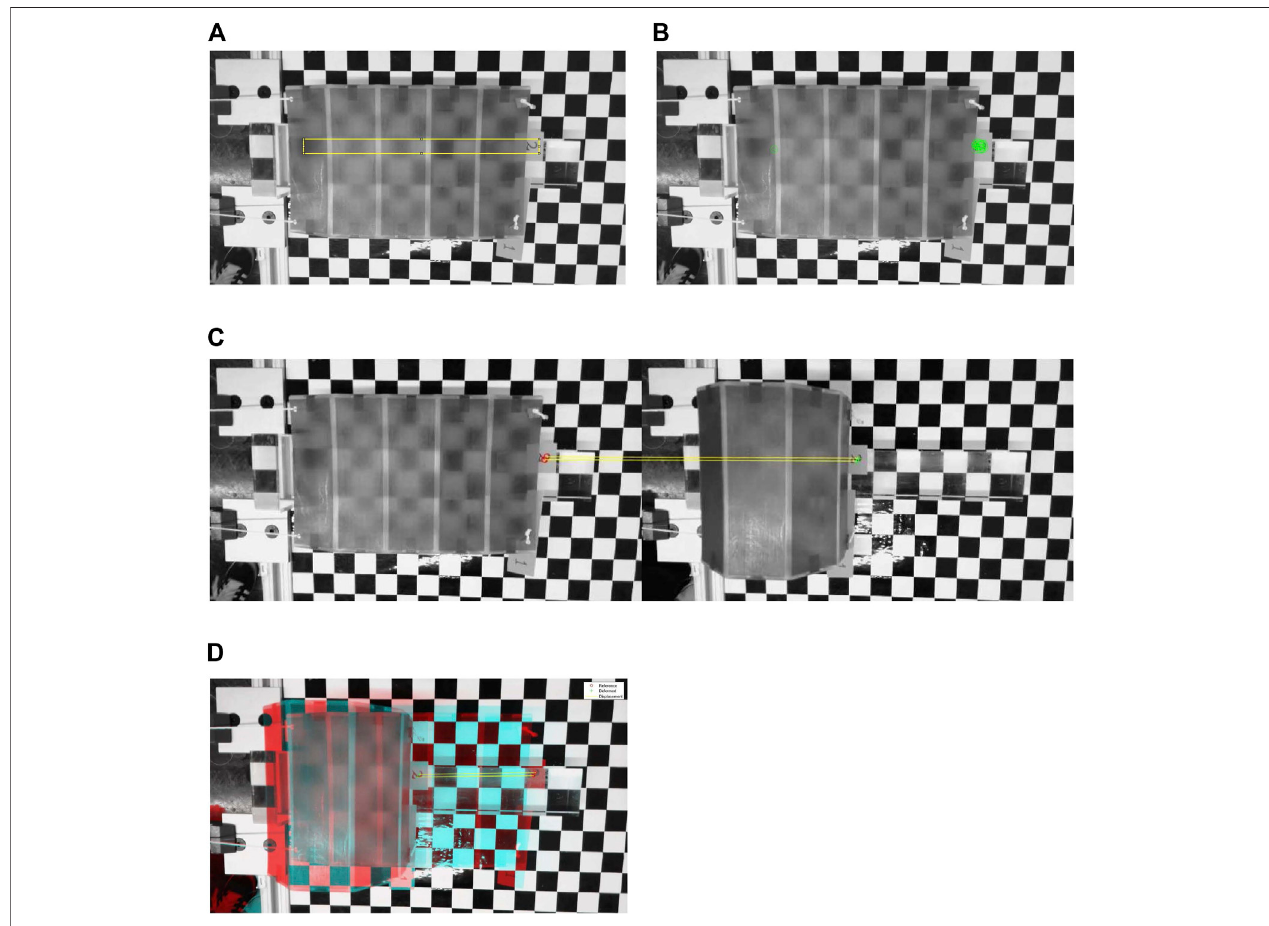
FIGURE 9 | Image-based object tracking using computer vision. (A) Selecting ROI for the OPB model, (B) Detected SURF features for tracking, (C) Matched features after eliminating the outliers, (D) Tracked features.